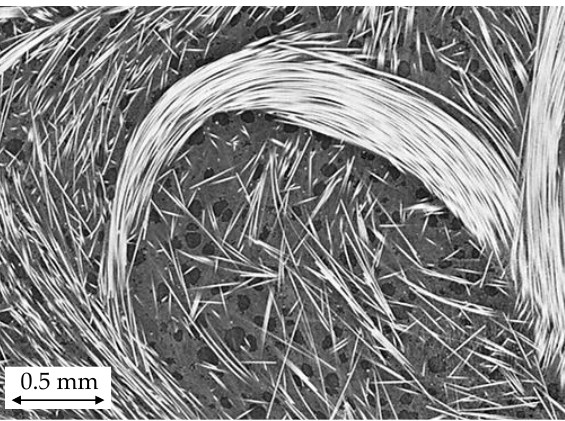
Figure 10. Undispersed fiber bundle in foamed door panel at location 3. Dark area indicates cells, gray area represents the polymer matrix, and fibers are shown in white.